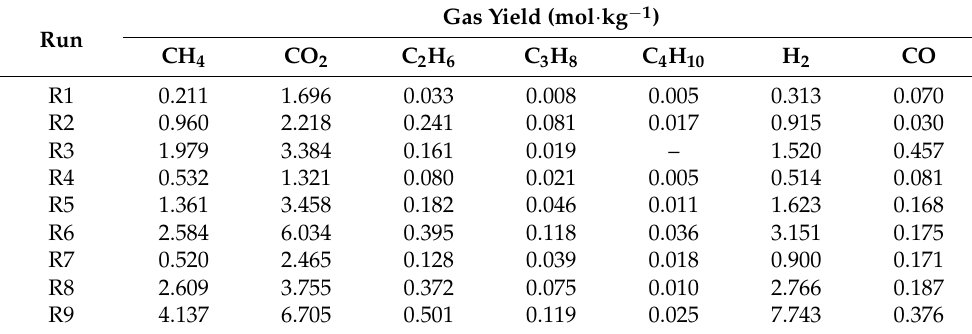
sented in Table 4. where m feed was referred to the mass of feed. Table 4. Evaluation of gas